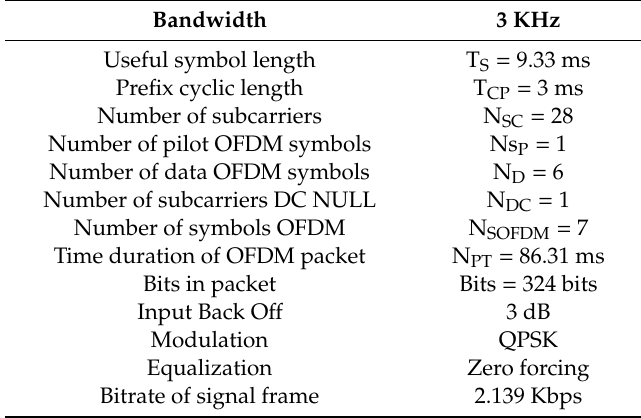
Table 1. Orthogonal frequency-division multiplexing (OFDM) configuration for NVIS